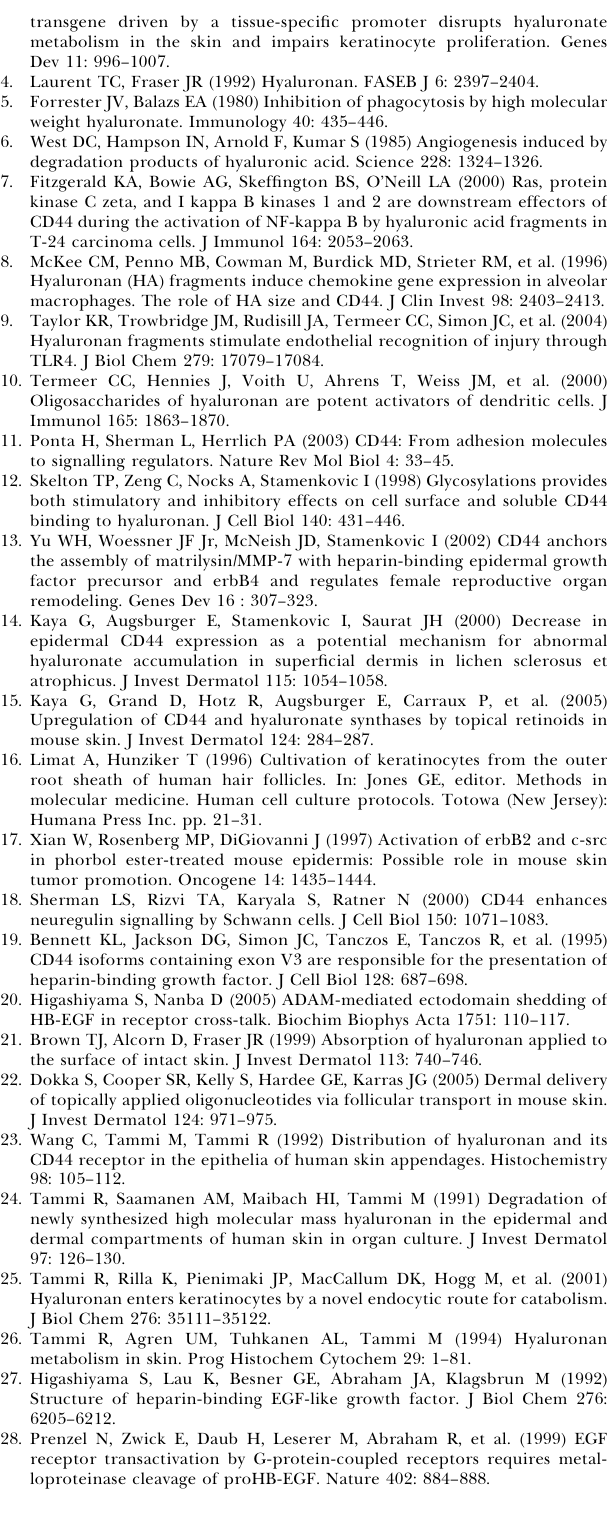
Figure S1. The Effect of TPA on CD44 (cid:1) / (cid:1) Mouse Skin